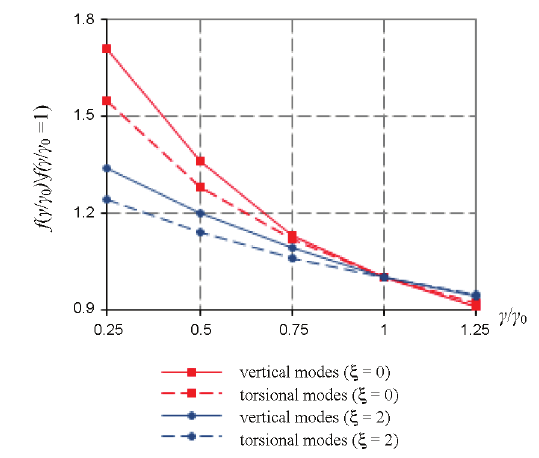
Fig. 12. The ratio between the frequency of the model with the variable mass f ( γ/γ 0 ) of the deck and that of the original system f ( γ/γ 0 = 1 ) for all vertical and torsional modes versus the ratio γ / γ 0 of the mass density of the deck considering two values of stiffness parameters ξ = 0 and ξ = 2.0 of the cable